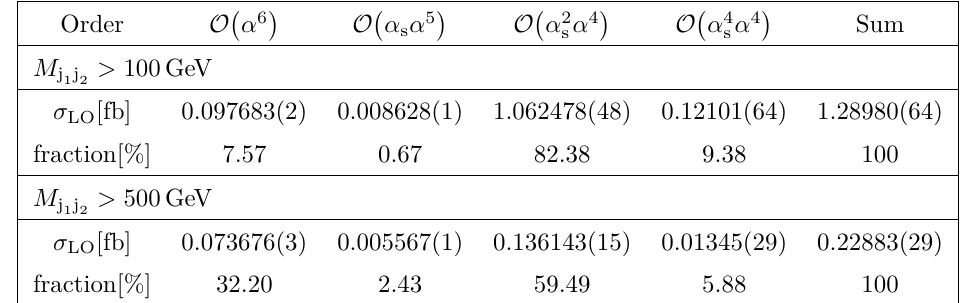
(cid:0) (cid:1) (cid:0) (cid:1) (cid:0) (cid:1) α 6 , O α s α 5 , O α 2 α 4 , s